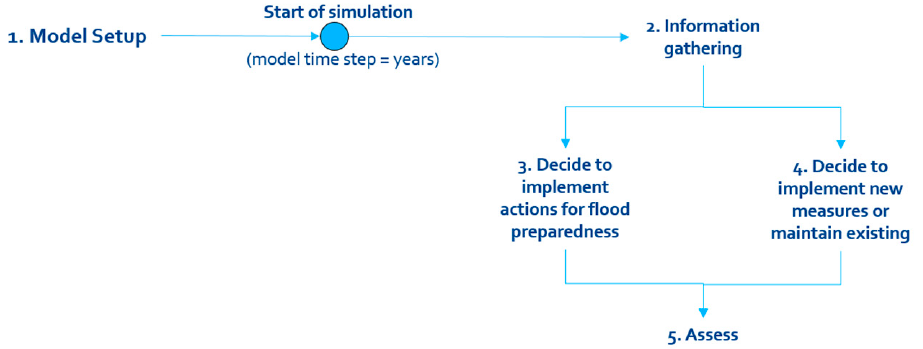
Figure 3. Core procedure of the PEARL ABM SAS.